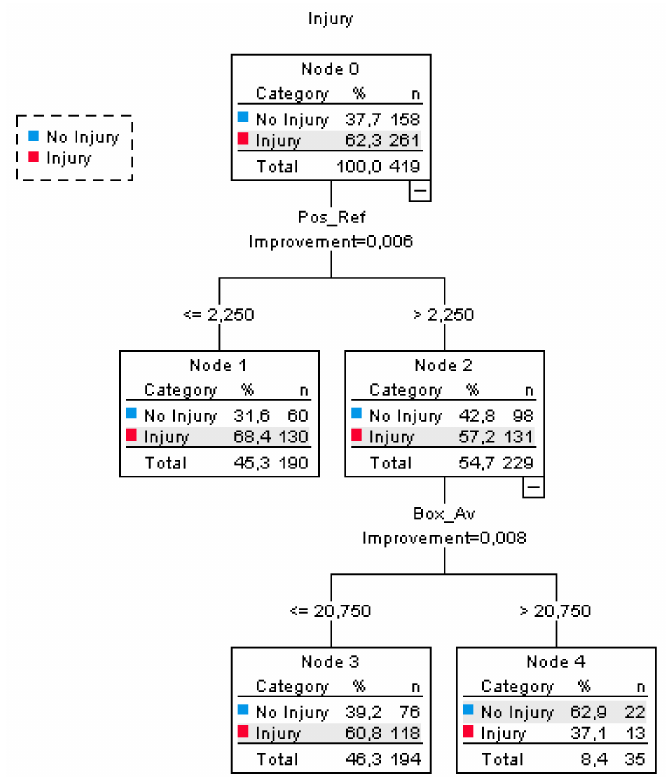
Figure 1. The results of the Classification and Regression Trees analysis showing the four terminal nodes. Predictors included in the CRT analysis were: perceived stress, square hop test, One-leg Long Box Jump Test (OLLBJ), active coping, instrumental support, planning, acceptance, emotional support, positive reframing, humor, religion, number of training hours/week, number of match hours/week,